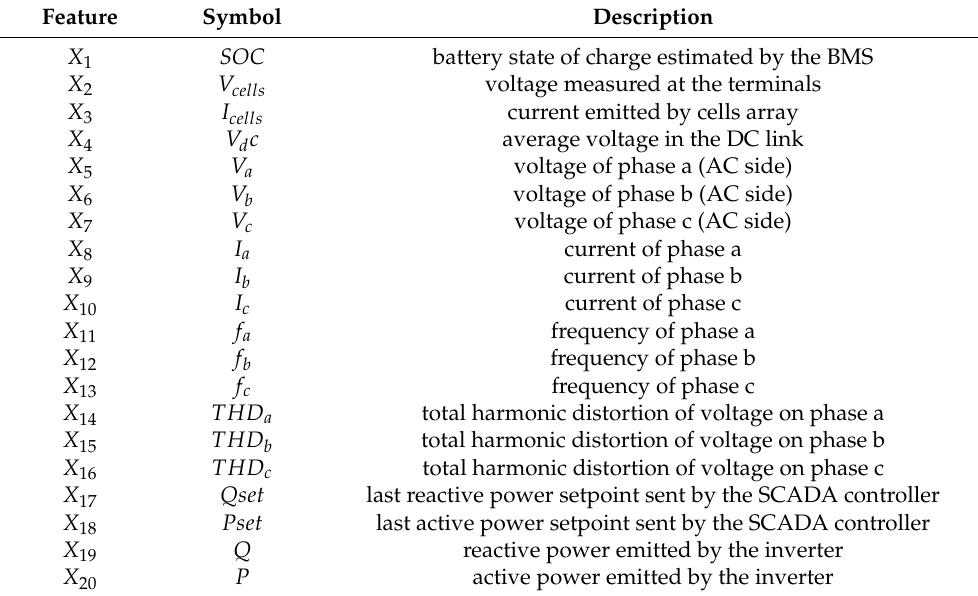
Table 1. List and description of the features.